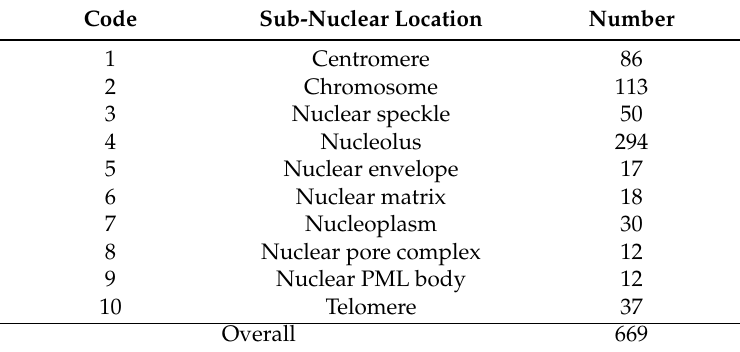
Table 3. Protein benchmark Dataset 2 of ten sub-nuclear locations.